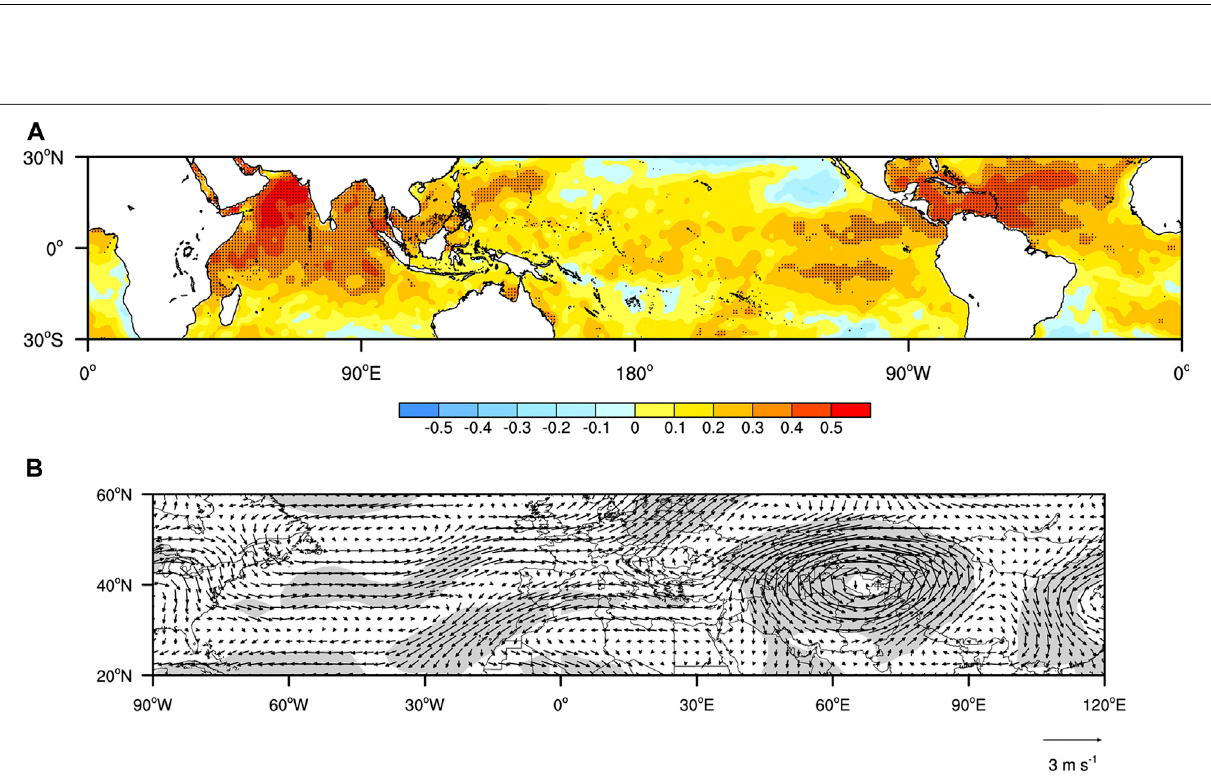
Frontiers in Earth Science |